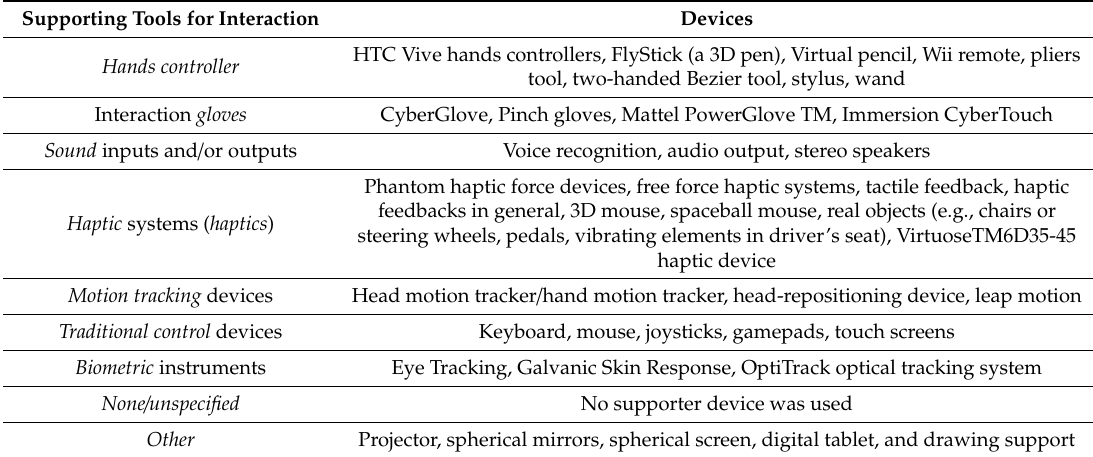
Table 4. Categories of VR supporting tools for interaction with a 3D model in the virtual environment.